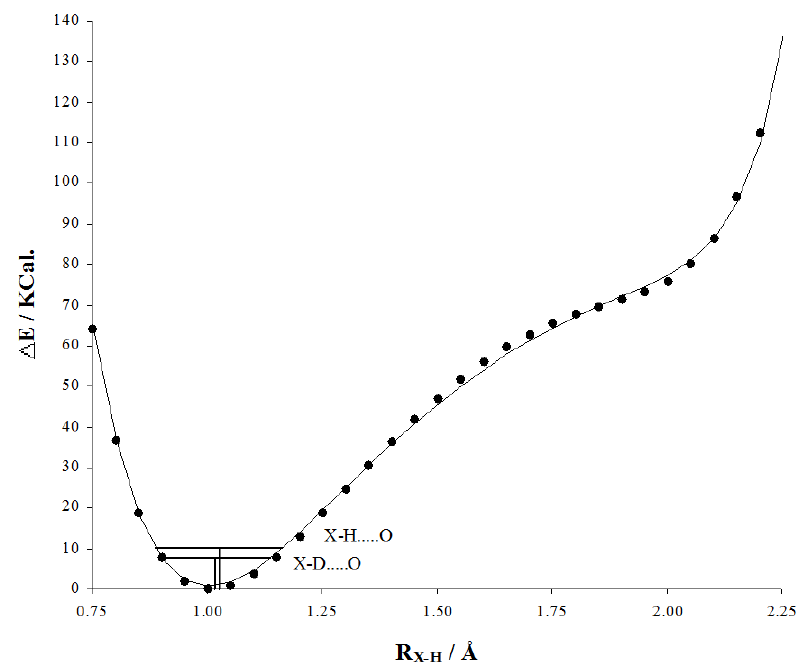
Figure 3. Calculated hydrogen bond potential of the formamide dimer